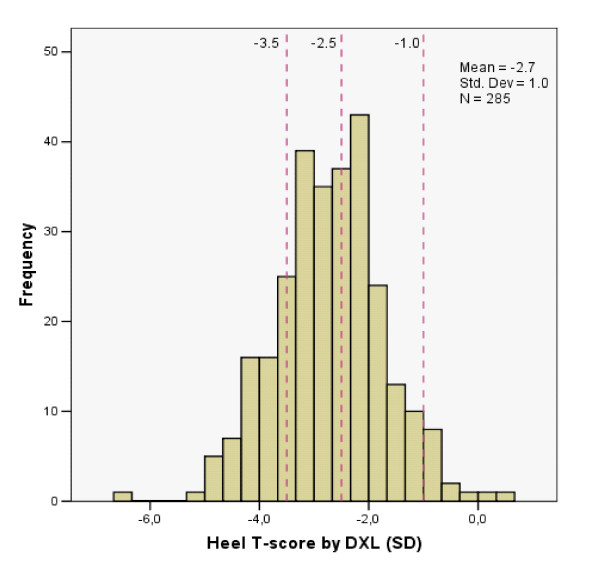
Heel BMD by DXL technique on 285 women in PHC population.